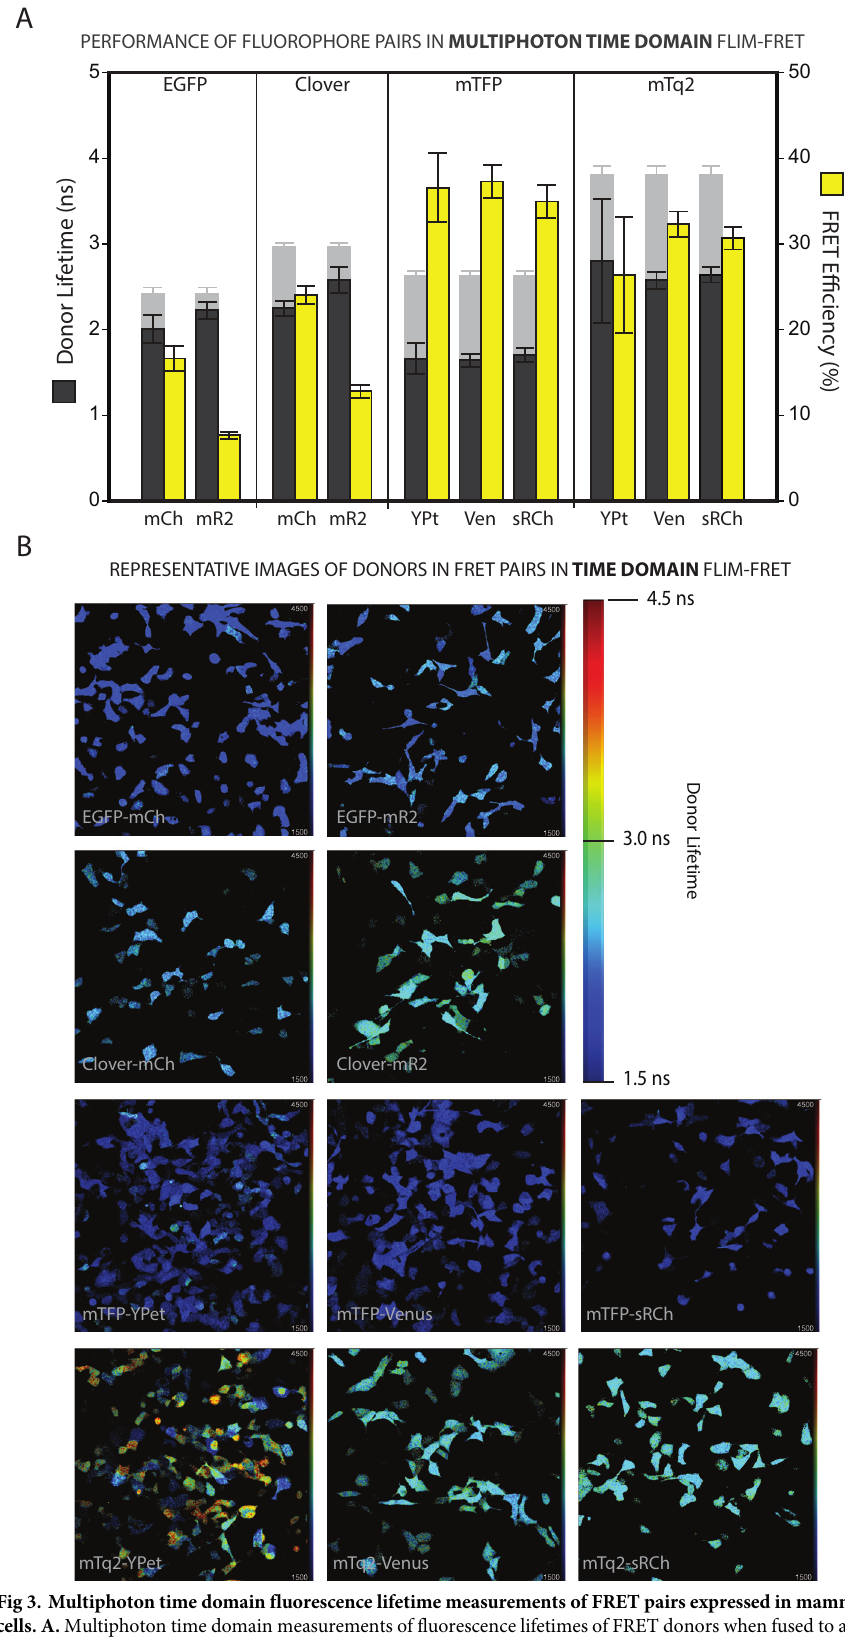
Fig 3. Multiphoton time domain fluorescence lifetime measurements of FRET pairs expressed in mammalian cells. A. Multiphoton time domain measurements of fluorescence lifetimes of FRET donors when fused to